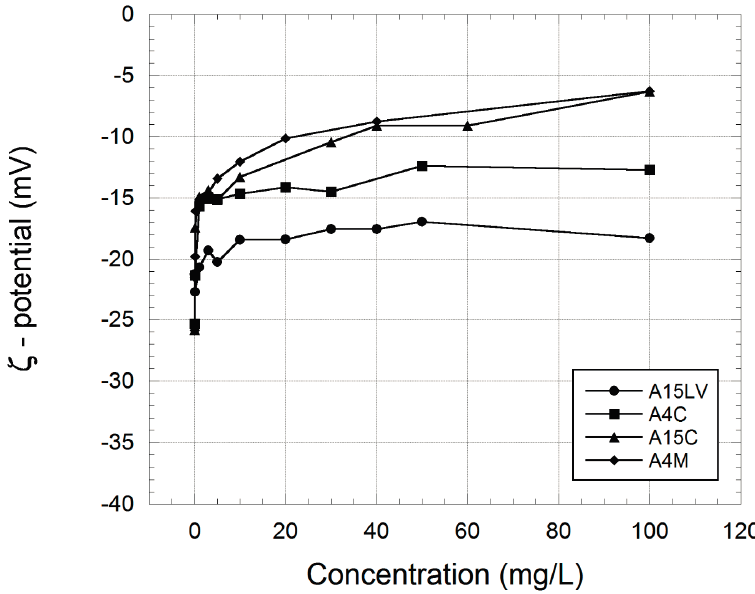
Figure 12. ζ -Potential (expressed in mV) of silica particles with an average 0.5- μ m diameter dispersed in water at 20 °C in the presence of increased amounts of methylcelluloses with different molecular weights. The lines are added to guide the eye